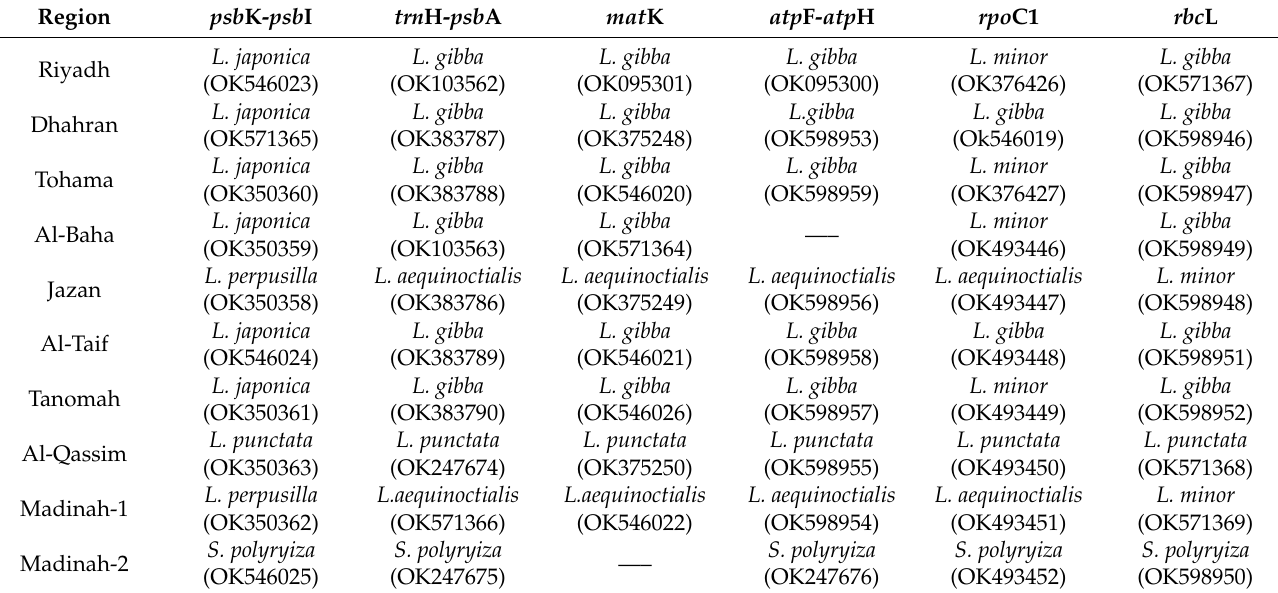
Table 3. DNA barcoding-based identifications and accessions number among 10 duckweeds clones.